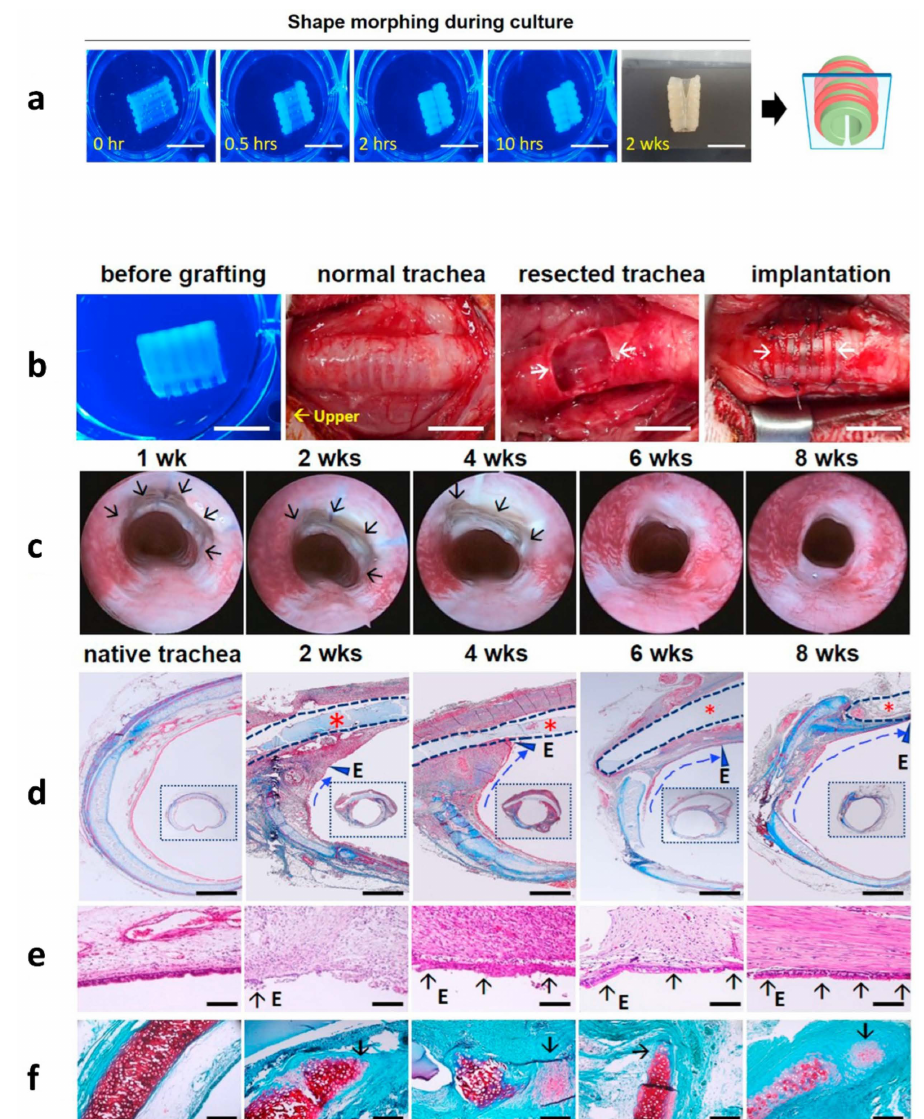
Figure 6. Implantation of the 4D-bioprinted trachea after in vitro culture. ( a ) Culture of 4D-bioprinted trachea in vitro. Shape morphing was achieved via in vitro culture: scale bars, 1 cm. ( b ) Transplanta- tion of the fabricated trachea. The fabricated trachea was transplanted into an injured trachea rabbit model. Scale bars, 1 cm. ( c ) Bronchoscopic pictures of the intrinsic trachea and fabricated trachea at 1, 2, 4, 6 and 8 weeks post-implantation. Arrows indicate transplanted trachea. ( d ) Masson’s trichrome (MT) staining. The 4D-bioprinted trachea (marked as asterisks and dotted lines) was identified on the transplanted site: scale bars, 1 mm (1 cm for small boxes images). The area of the regenerated epithelium is marked as E and a dotted line with an arrowhead. ( e ) HE staining. Neo-respiratory epithelium (marked as E and short arrow) was identified at 2 weeks post-surgery. Scale bars, 100 µ m. ( f ) Safranin O staining (immature cartilage is marked with a short arrow). This neo-cartilage had a greater cellular density and less dense sulfated glycosaminoglycan staining than normal tracheal cartilage: scale bars, 250 µ m. Adapted from [39] with permission from